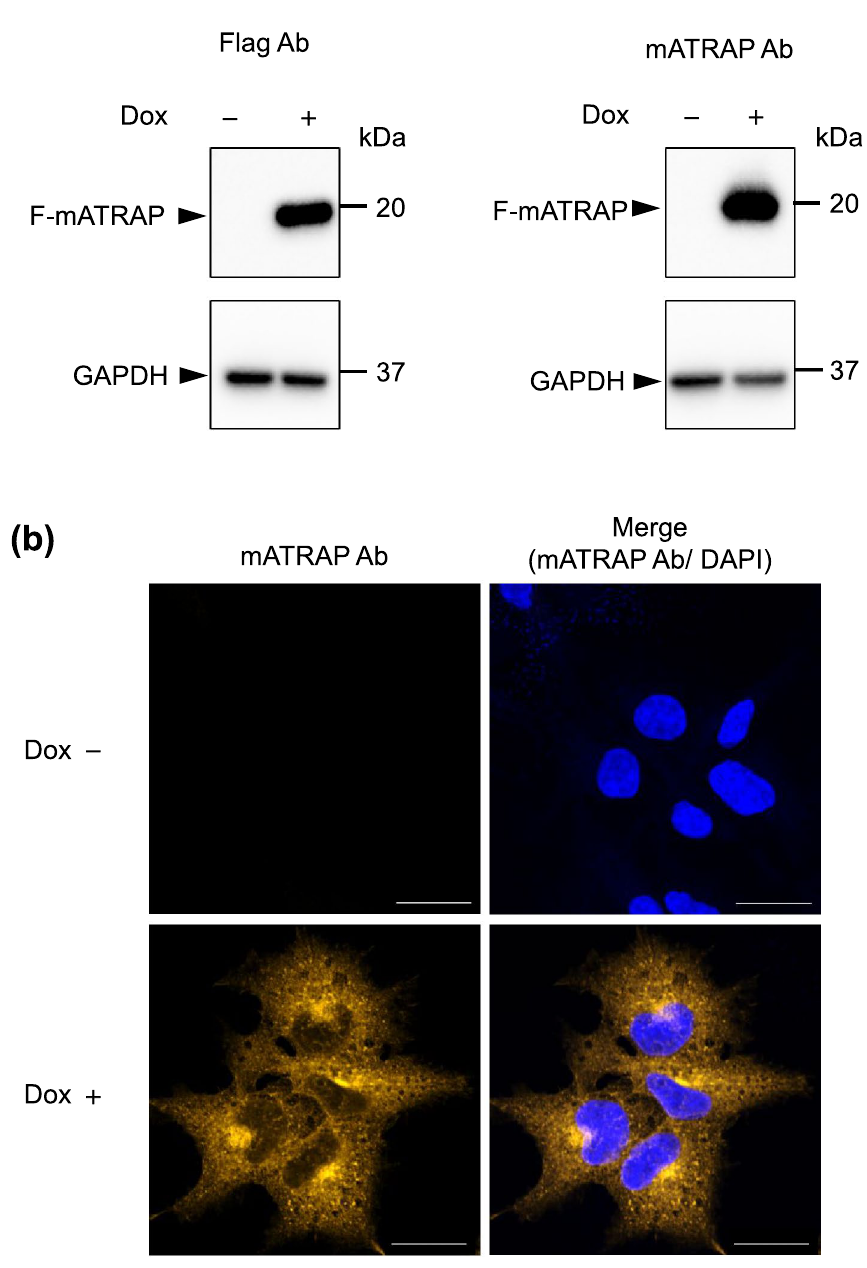
Figure 1. Establishment of HEK293 cells capable of Dox-dependent induction of F-mATRAP expression (HEK293_F-mATRAP cells). ( a ) Western blot analysis using an anti-Flag antibody (left) and an anti-mATRAP antibody (right), with or without Dox treatment (Dox+/Dox−). Glyceraldehyde 3-phosphate dehydrogenase (GAPDH) was probed as a loading control. ( b ) Immunofluorescence analysis using an anti-mATRAP antibody with or without Dox treatment (Dox+/Dox−). Scale bars: 20 µm. Blue: DAPI; Orange: anti-mATRAP antibody. Ab :